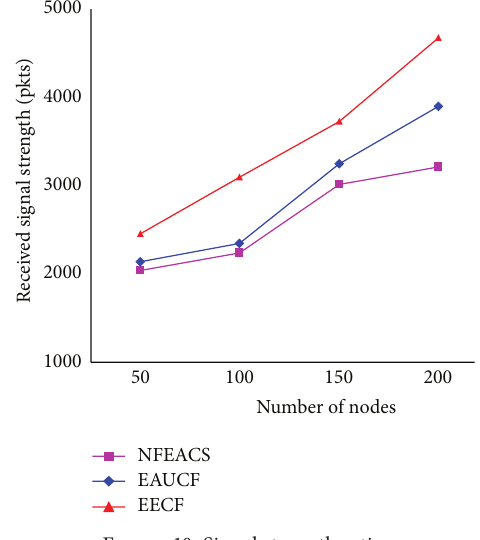
Figure 10: Signal strength ratio. Table 2: Total remaining energy for three schemes. Algorithm Number of alive